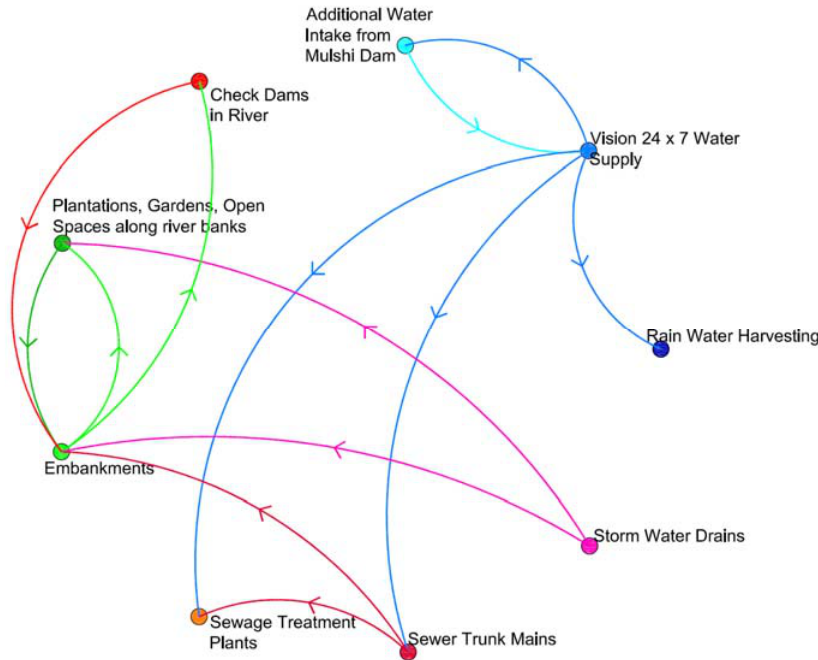
Figure 8. Mapping relationships between adaptation responses The arrows originating from an adaptation responses and terminating at other the adaptation response(s) is the representation of relationship between the responses, i.e., change in one response is most likely to lead change in the other response.